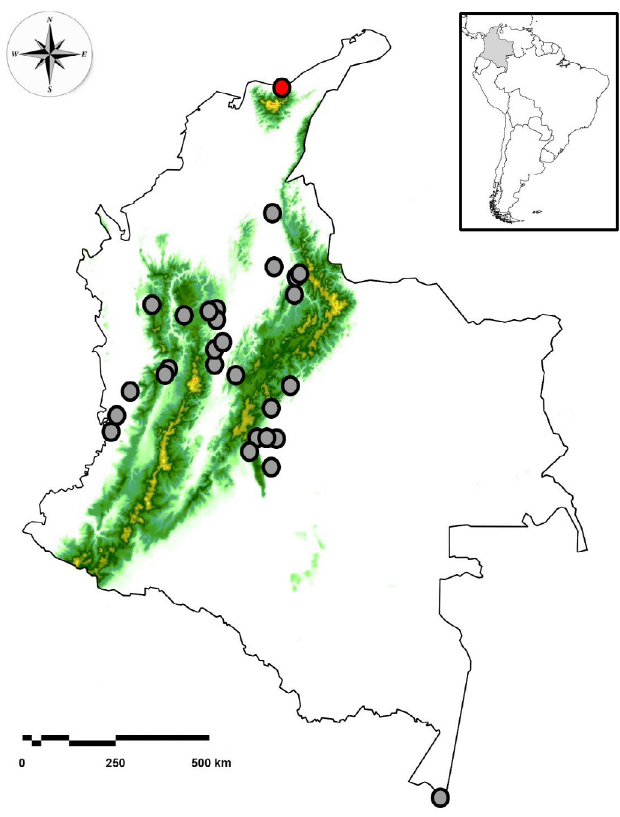
Figure 3. Map of Colombia showing the distribution of Ninia atrata